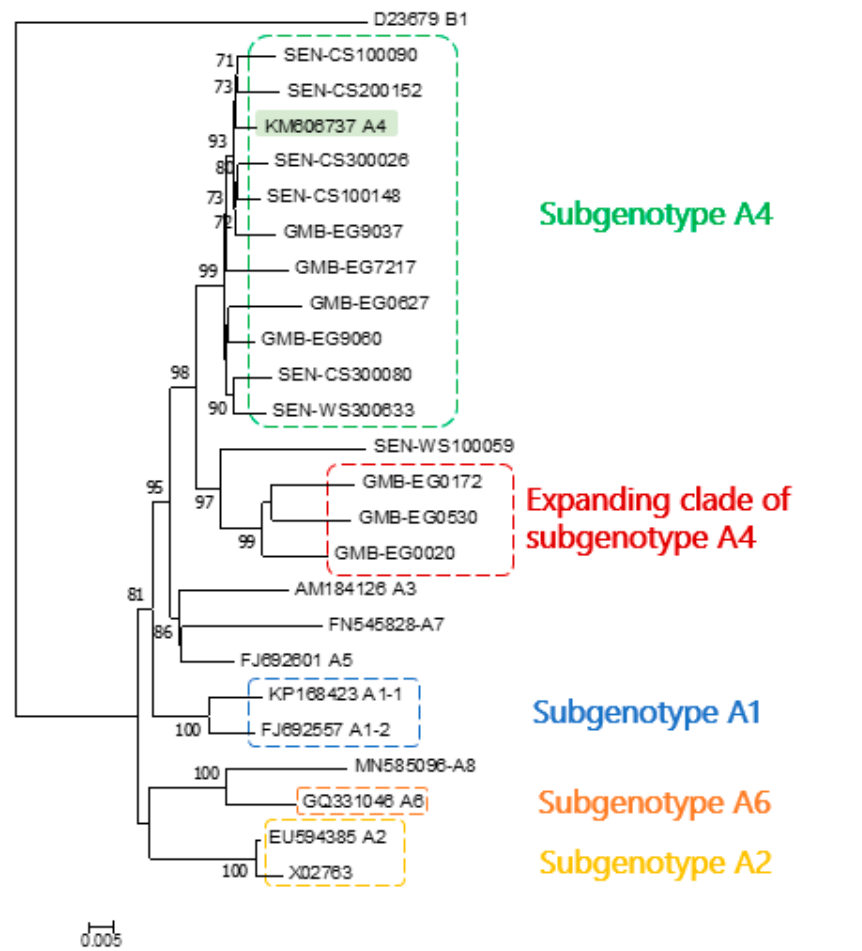
Figure 2. Phylogenetic tree reconstructed using the maximum likelihood method implemented in the PhyML program (v3.1/3.0 approximate likelihood-ratio (aLRT)). The general time-reversible (GTR) substitution model was selected, assuming an estimated proportion of invariant sites (of 0.480) and five gamma-distributed rate categories to account for rate heterogeneity across sites. The gamma shape parameter was estimated directly from the data (gamma = 0.504). Reliability for the internal branch was assessed using the aLRT test (SH-Like). Samples sequenced in this study are identified by the prefixes GMB and SEN. The numbers at each node correspond to the aLRT supports (greater than 70%). Table 1. Percentage (mean ± SD) of nucleotide divergence between Hepatitis B virus (HBV) sub- genotype A full sequences and expanding clade of subgenotype A4.